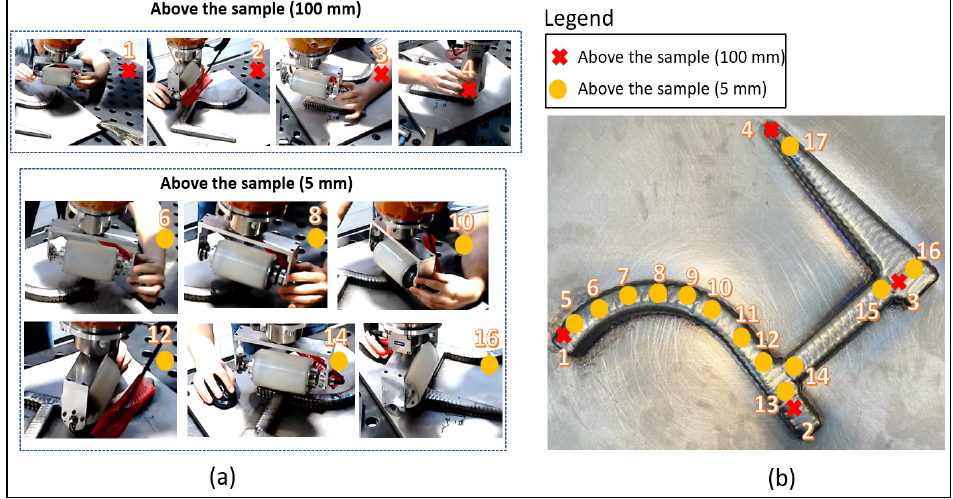
Figure 7. Kinesthetic teaching: ( a ) Four points recorded 100 mm above the workpiece, which are the starting, between, and endpoints during the three areas of inspection. Thirteen points were recorded by manipulation of the end effector 5 mm above the specimen, and at these points, the adaptive FT control was enabled to perform the UT inspection for defects; ( b ) top view of the complex-shaped WAAM component showcasing the taught positions generated from the kinesthetic path planning .